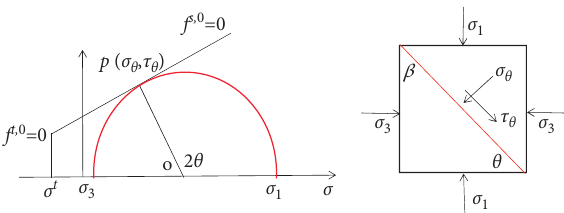
Figure 19: Theoretical analysis diagram of single joint sandstone.